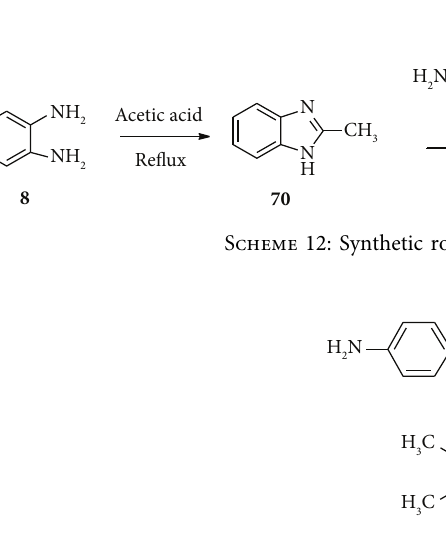
; 69b R= 3-OCH ; 69c R= 2-NO ; 69d R= 4-CF ; 69e R=3,4-diOCH 3 3 2 3 Scheme 11: Synthetic routes toward compound 69 derivatives.